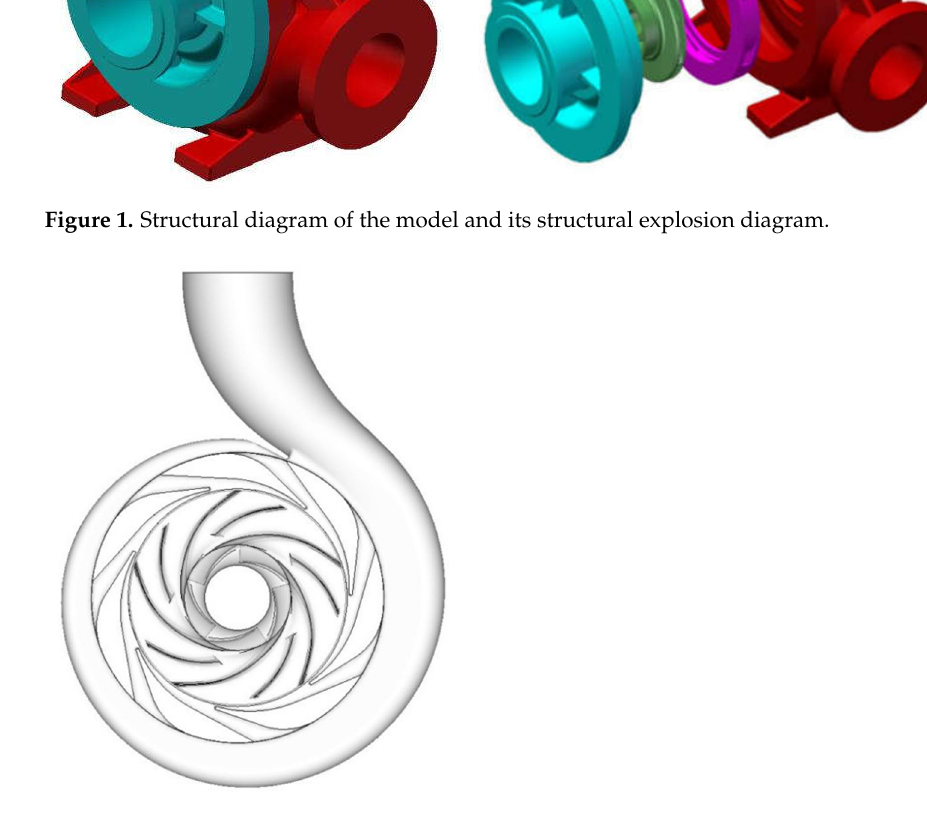
Figure 2. 3D perspective of the region of the fluid. Table 1. Specifications of the test section.